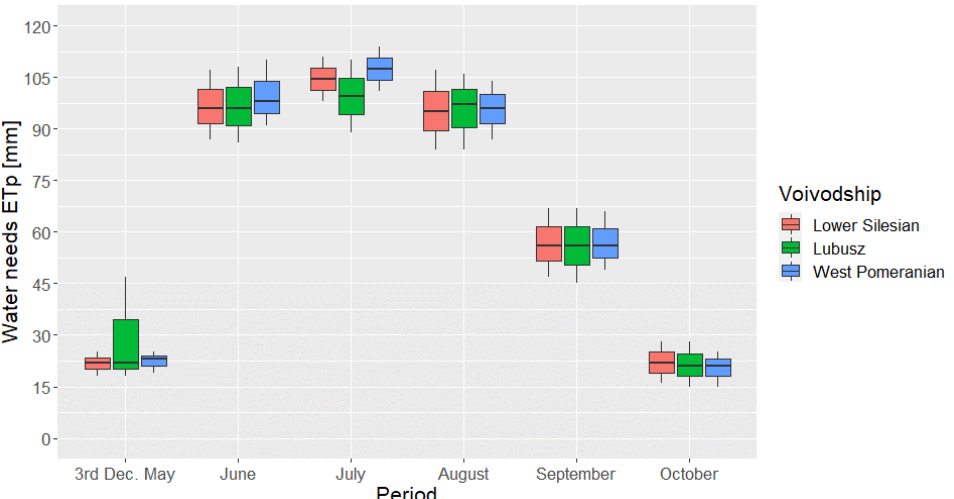
Figure 6. Water requirements (ETp) in the growing season calculated for individual voivodeships in 1981–2010.